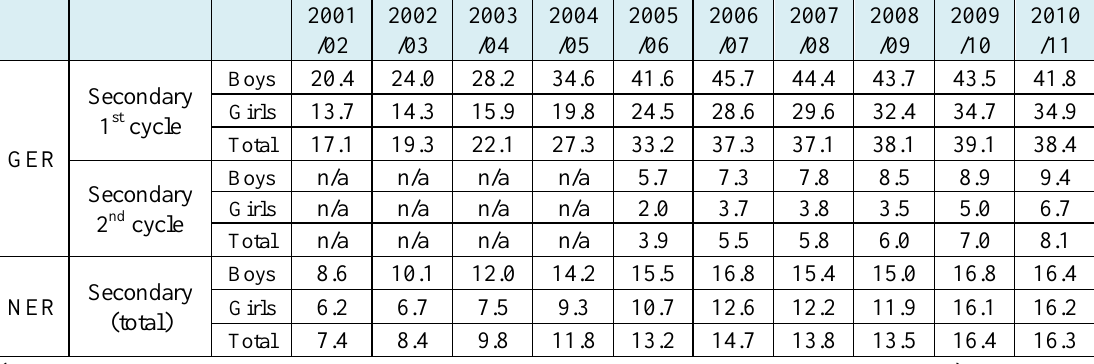
Table 4-5: Secondary Gross and Net Enrollment Rates (2001/02 - 2010/11)